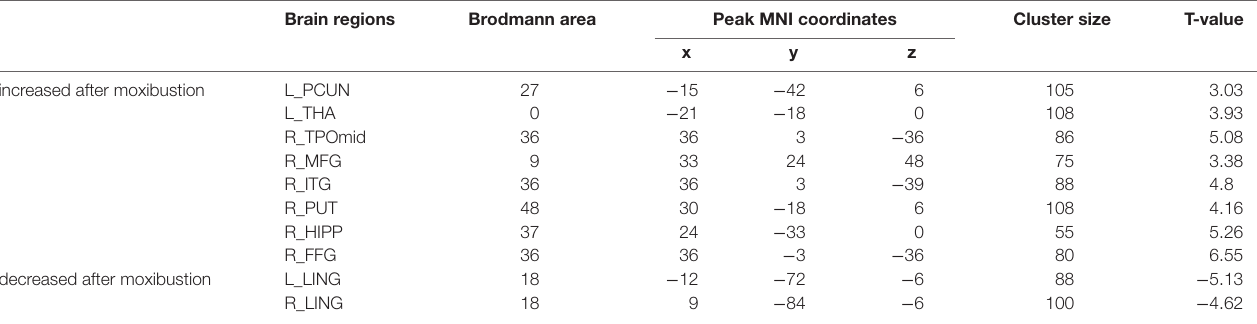
TABLE 4 | Brain regions demonstrating altered ALFF values of MCI patients after